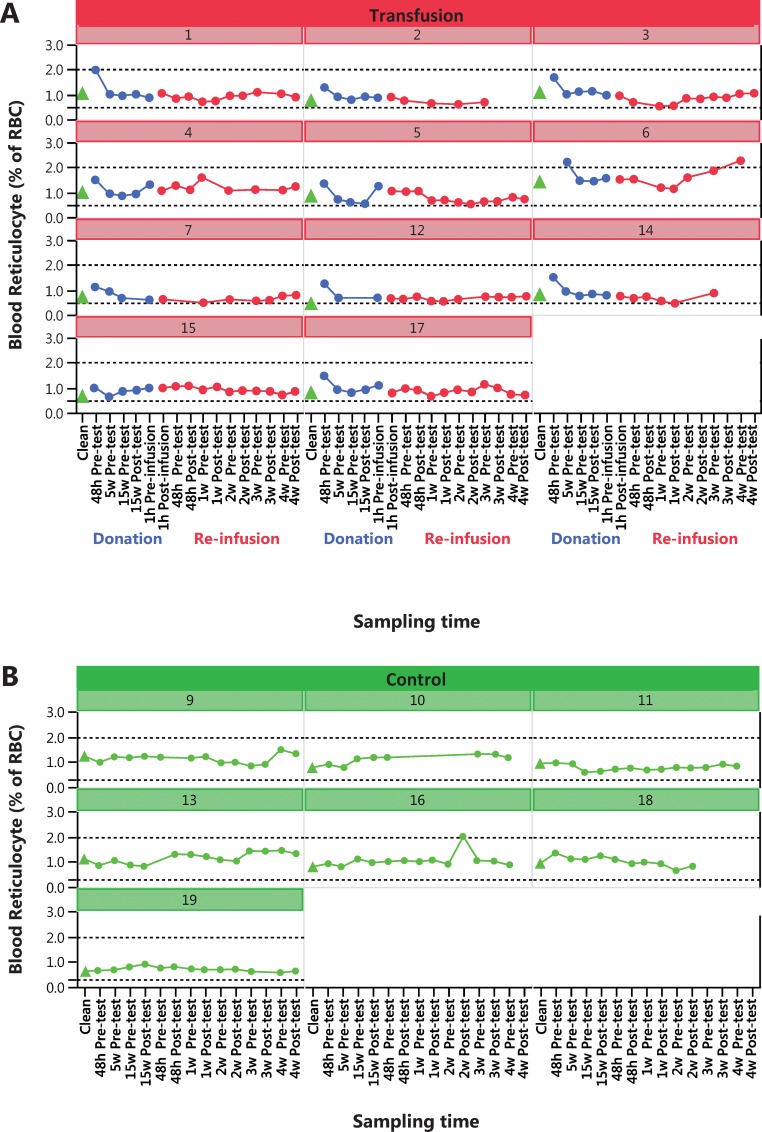
Part A of the Study.Individual blood reticulocyte count per RBC (%). Results from analysis of 161 blood samples from transfused men (N = 11, Nr 1–17) in Panel A, and 93 samples from control men in Panel B (N = 7, Nr 9–19). All samples were taken in parallel during 22 weeks (Fig 1). Transfused subjects donated two units (900 mL) blood and were re-infused with the washed, cryopreserved RBC fraction at week 17 (Fig 1). Control subjects were sampled and tested at the same time intervals, except one hour before and after the RBC reinfusion. For reference, a dashed black line at 0.5% and 2% is suggested to be the individual upper and lower limits for indication of autologous blood doping [60].